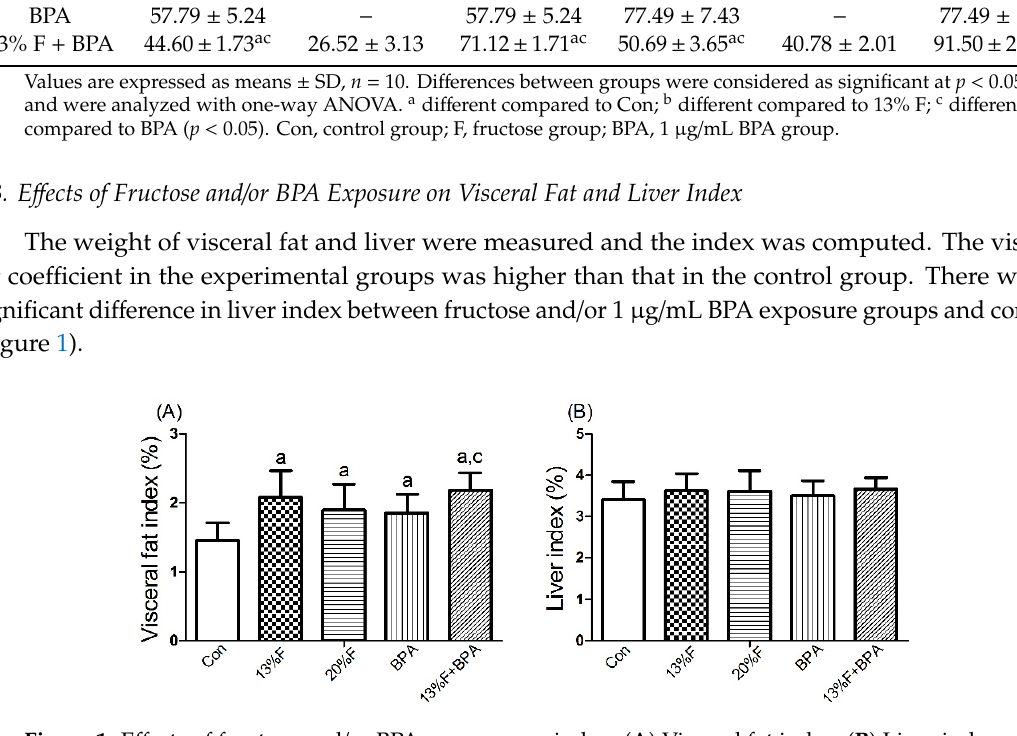
Table 2. The e ff ect of fructose and / or BPA exposure on energy intake in male rats (kcal / rat / day). Table 2. The effect of fructose and/or BPA exposure on energy intake in male rats (kcal/rat/day). Month 1 Month 2 Group Month 1 Month 2 Group Food Water Total Food Water Total Food Water Total Food Water Total Con Con 57.48 ± 6.03 − 57.48 ± 6.03 76.33 ± 3.48 − 76.33 ± 3.48 13% F